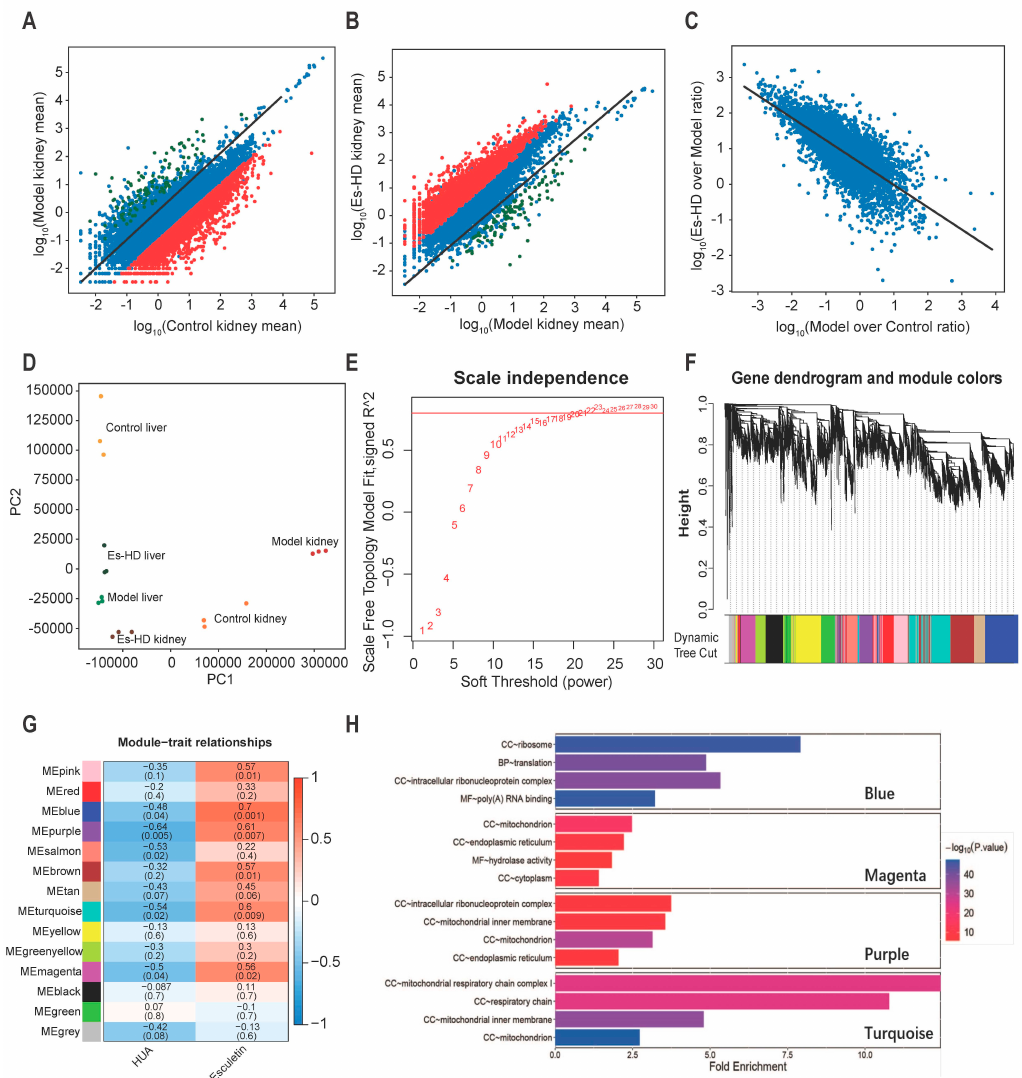
Figure 6. RNA-seq analysis reveals transcriptional reversion by esculetin in the kidney. ( A ) Scatter plots of the gene expression in Model vs. Control groups. Black line: y = x line. ( B ). Scatter plots of gene expression in Es-HD versus Model groups. Red (green) dots show genes that were down- (up-) regulated by 100 fold ( A ) which were revered after esculetin treatment ( B ) Black line: y = x line. ( C ) Scatter plots of gene expression in Model vs. Controls and Es-HD vs. Model ratios in the log 10 scale. Changes in the ratios indicated a perfect restoration. ( D ) PCA analysis of 18 samples using absolute gene expression data in the kidney and liver. The distance between di ff erent dots indicates their similarity. ( E ) x -axis: di ff erent power value; y -axis: r-square value after linear regression of -log10 (k) and log10 ( p (k)). K: connectivity of the gene nodes; p (k): possibility of such a node. Horizontal line: 0.8. ( F ) The result of gene clustering. Di ff erent colors show di ff erent gene modules. ( G ) Gene modules and phenotypes quantified using the Boolean variable (1 represents occurrence, 0 represents no occurrence) were used to calculate the correlation coe ffi cient, which is demonstrated as a heat map. p -values are shown in brackets. ( H ) The results of GO analysis in blue, magenta, purple, and turquoise modules. Among them, “BP” stands for biological process, “CC” stands for cell component, and “MF” stands for molecular